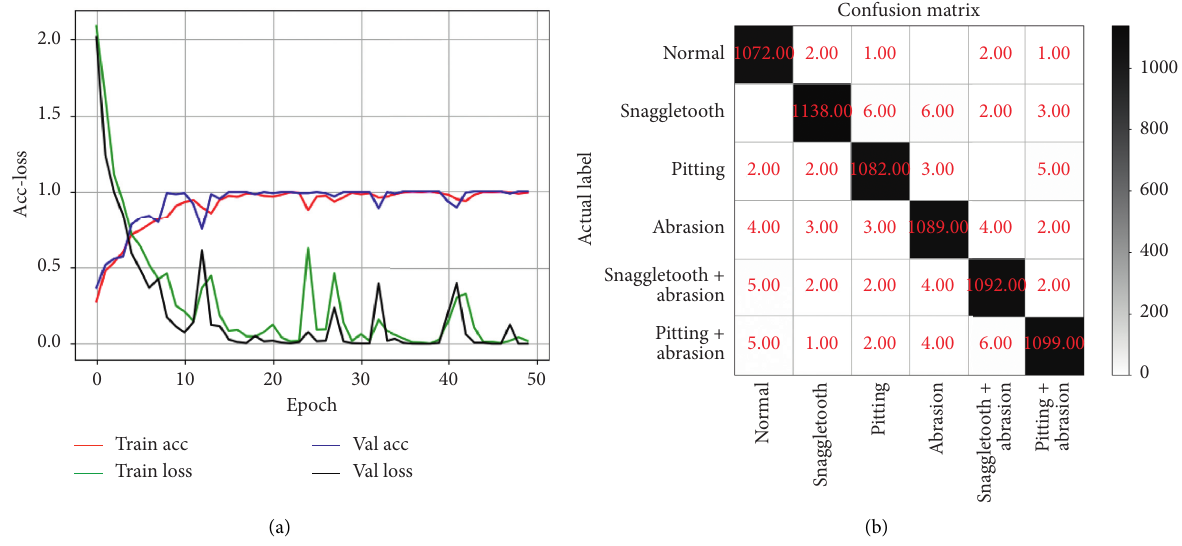
Figure 18: The 1-D CNN curve of accuracy rate and loss rate trained by PF of LMD and confusion matrix.